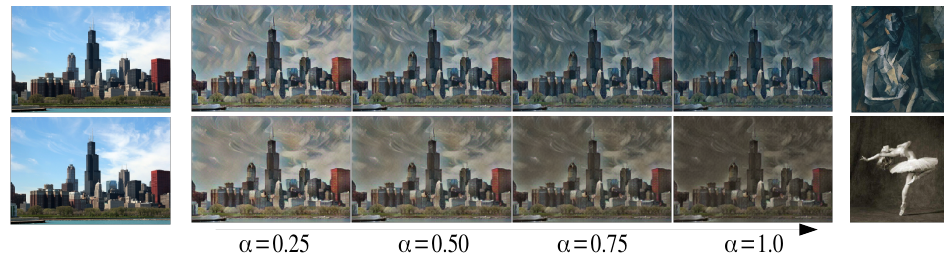
Figure 6. Examples of style strength control.